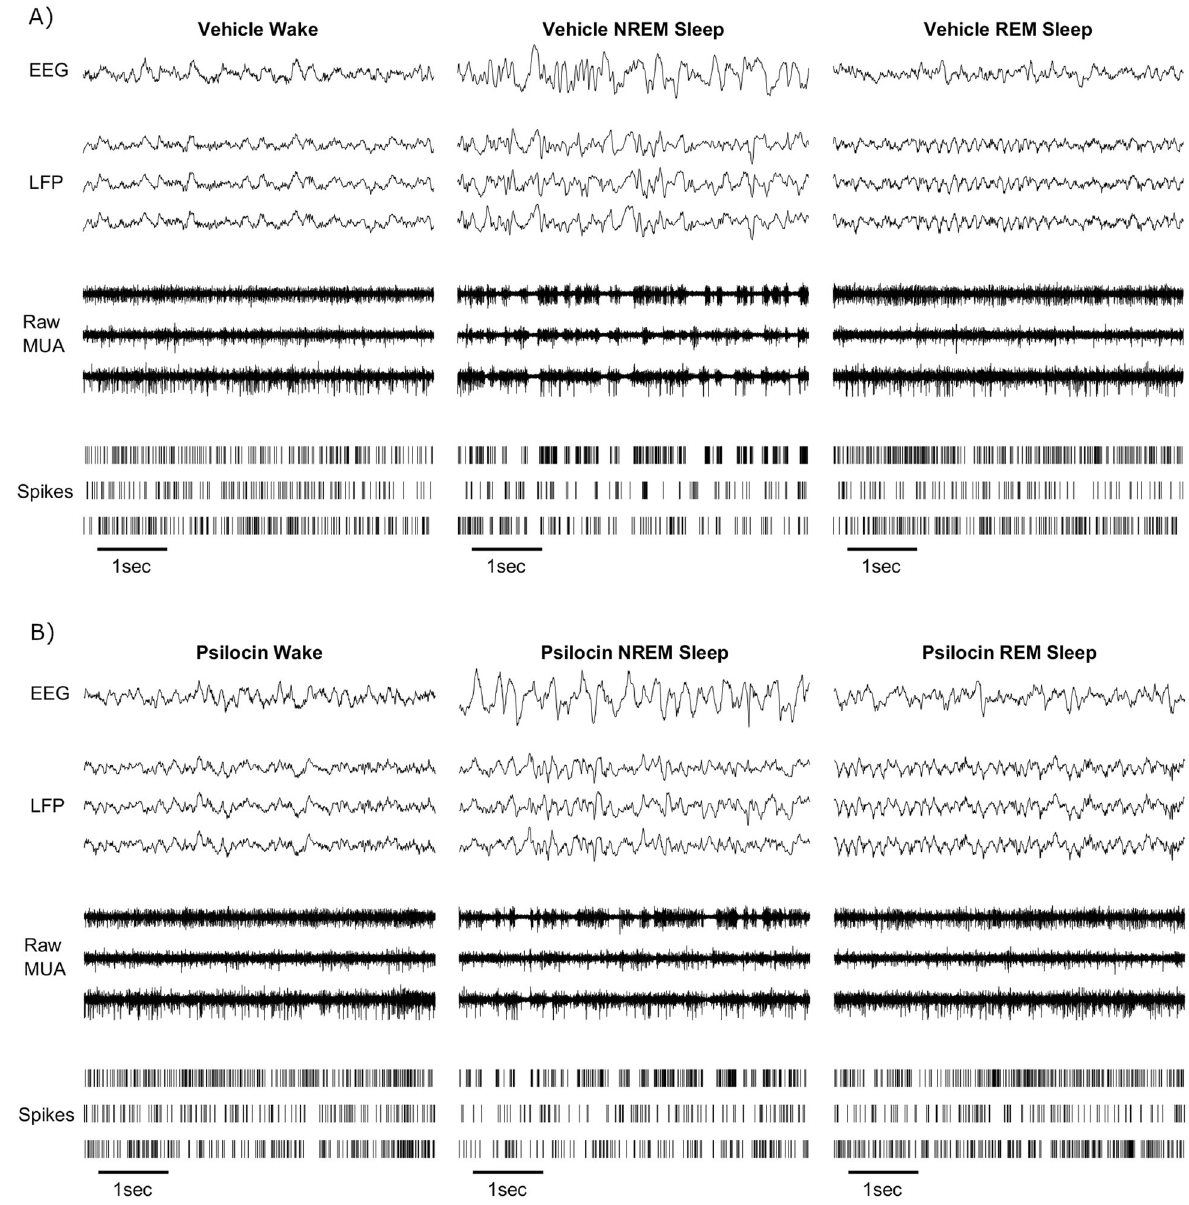
Fig. 1 Example wake, NREM and REM sleep signals following vehicle and psilocin injection. An example segment of 5 s duration of frontal electroencephalogram (EEG), 3 cortical local fi eld potentials (LFP), corresponding raw signal with multi-unit activity (MUA) and detected spikes in representative segments of waking, NREM and REM sleep, approximately 10, 40, and 70 min respectively, after A ) injection with vehicle solution, B ) injection with